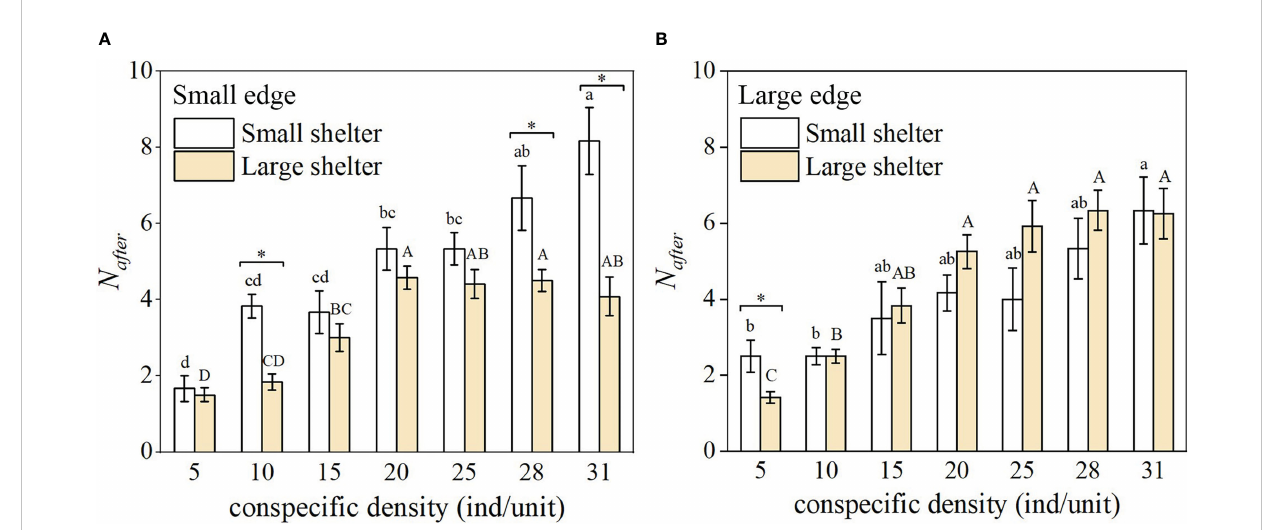
FIGURE 6 Number of fi sh in the shelter after disturbance ( N after ) (n = 6, mean ± SE) under the seven density treatments in the reef unit with (A) small edge and (B) large edge. Different lower-case letters represent signi fi cant differences among densities for the small shelter (Tukey ’ s test, p < 0.05); different capital letters represent signi fi cant differences among densities for the large shelter (Tukey ’ s test, p < 0.05); * indicates a signi fi cant difference between the small and large shelter for the same density and edge (Tukey ’ s test, p <